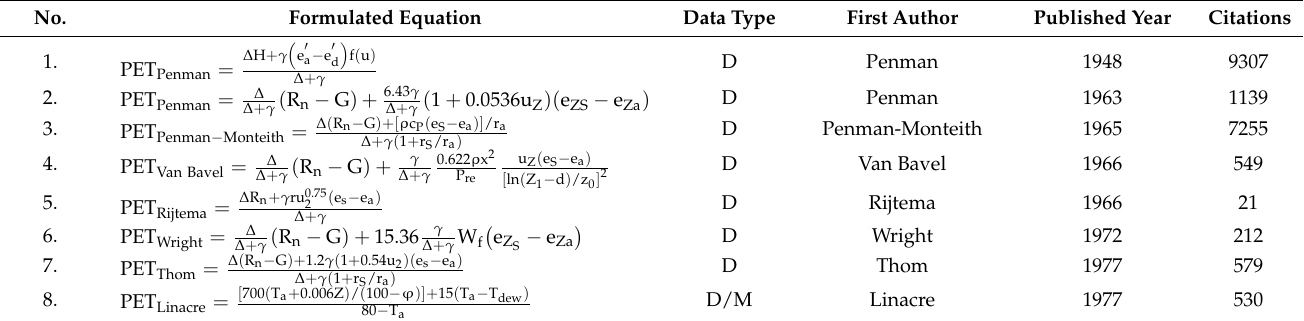
Table A3. PET combination-based equations.